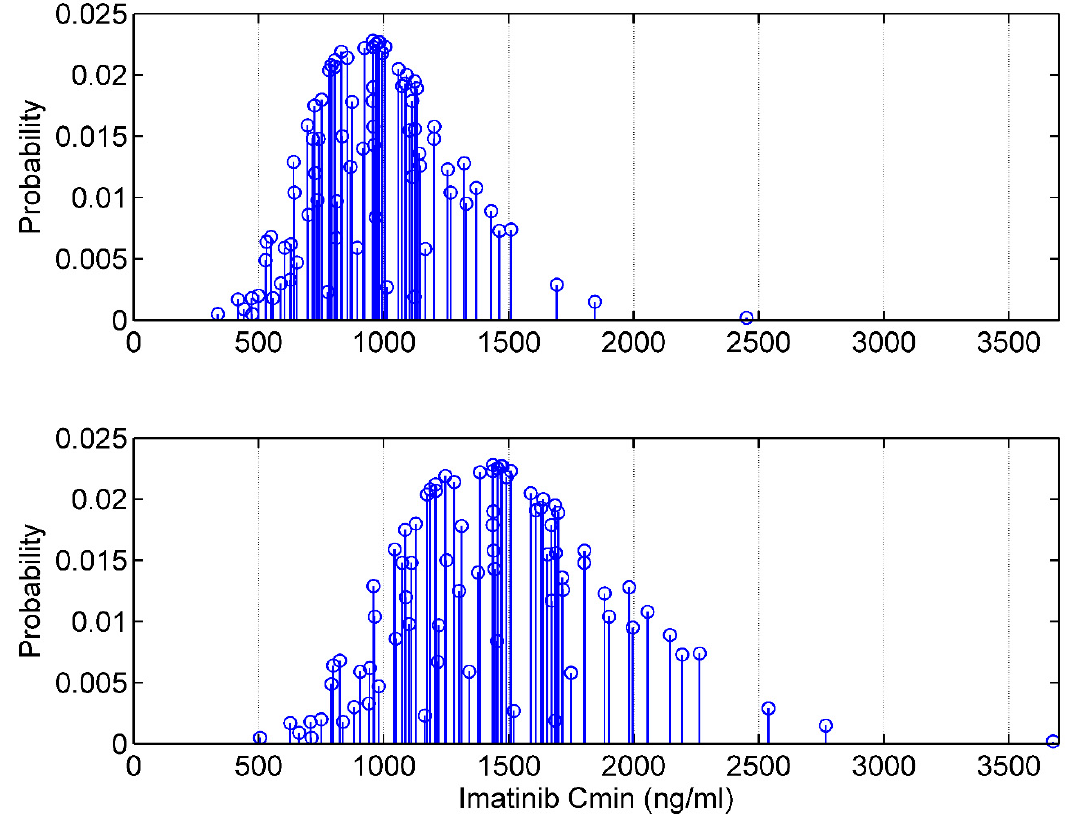
Figure 2. A priori discrete distribution of imatinib trough concentration at the steady state in a virtual patient. Upper panel, 400 mg/24 h; lower panel, 600 mg/24 h. The patient is a 60-year-old woman, her weight is 60 kg and she has CML.